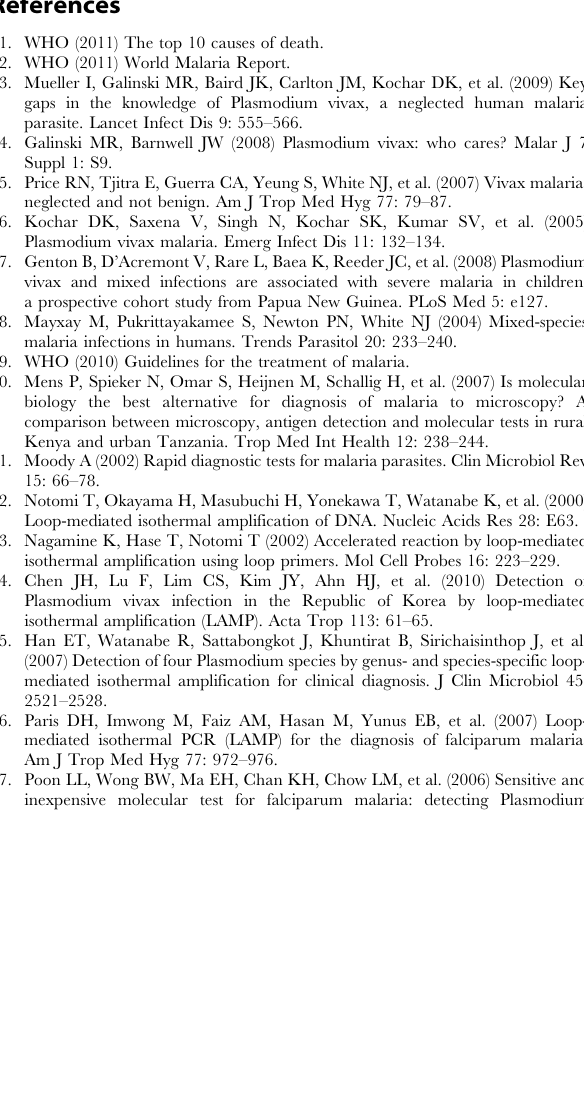
Figure S1 Comparison of the three sequences. The Pvr64 segment used to design the novel P. vivax primers was aligned with the P. knowlesi and P. falciparum sequences. The locations of the six LAMP primers are underlined (italicized sequences indicate location of the complementary sequences). Nucleotide differences found in the P. knowlesi (highlighted in green) and P. falciparum (highlighted in yellow) are